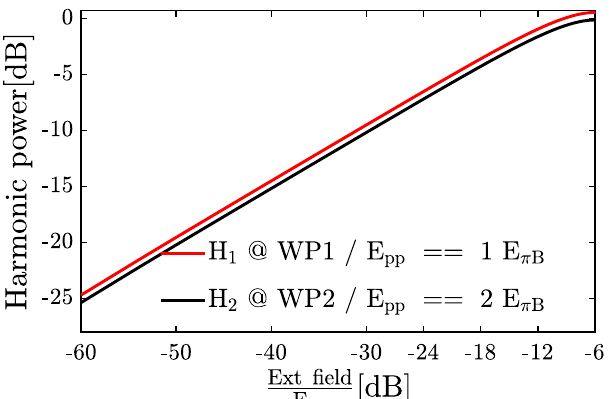
Figure 13. Comparison of the two most sensitive combinations of working point and modulation amplitude.